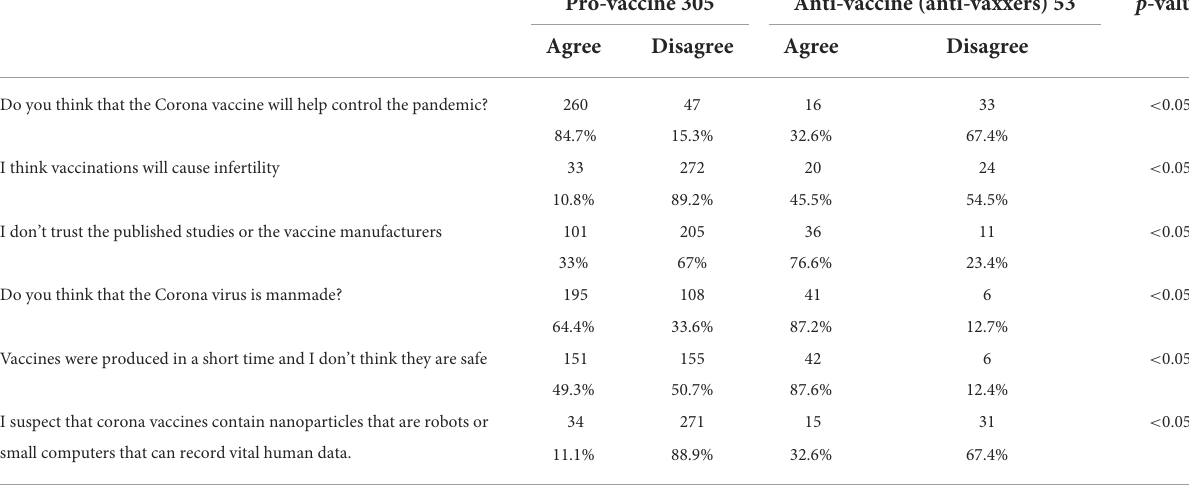
TABLE 5 Perception to ward COVID-19 vaccine, comparison between the pro vaccine and anti-vaccine (anti-vaxxers) groups in the sample. Pro-vaccine 305 Anti-vaccine (anti-vaxxers) 53 Agree Disagree Agree